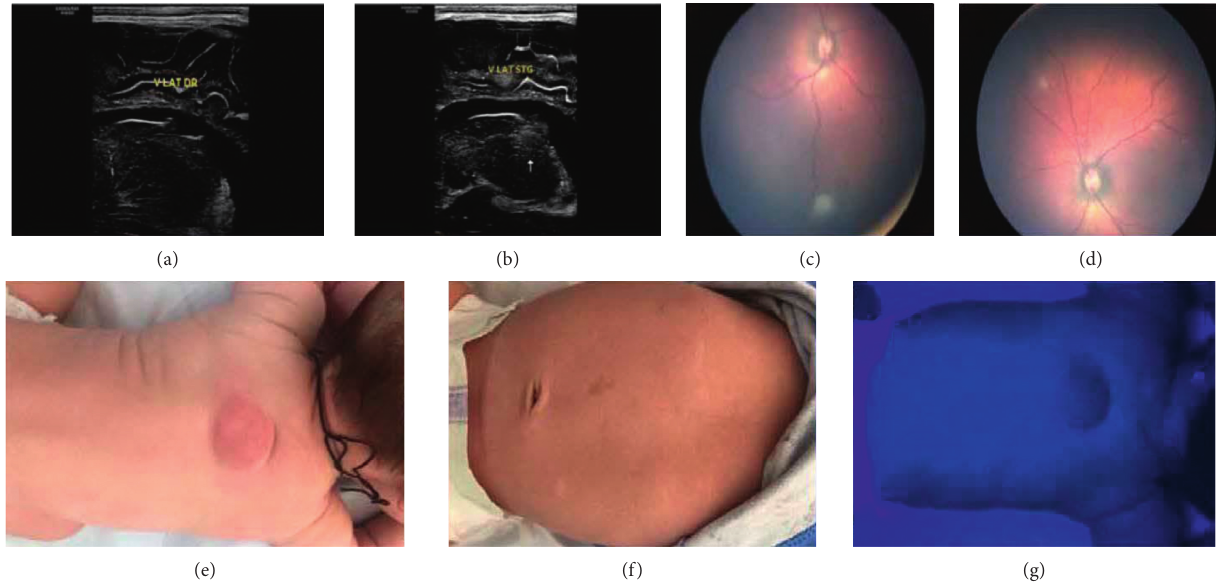
Figure 3: (a, b) Subependymal nodules, 8 weeks postnatal—right parasagittal section (a) and left parasagittal section (b); (c, d) multiple retinal hamartomas—indirect ophthalmoscopy; (e) Shagreen patch; (f) hypomelanotic macules—ash leaf; (g) hypomelanotic mac- ules—confetti-like (Wood’s